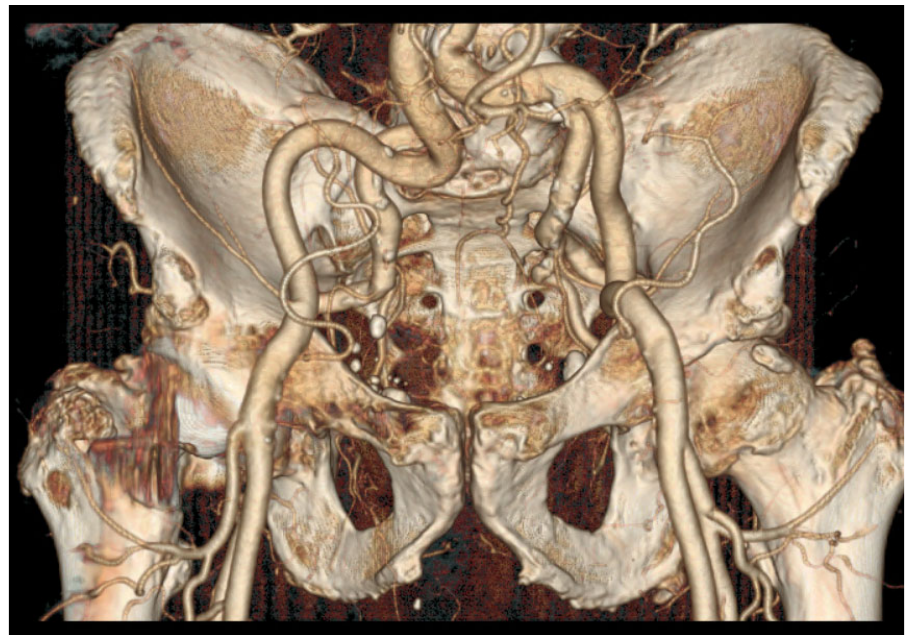
Figure 1. A CT scan with a 3D reconstruction showing very tortuous iliac arteries and very acute right internal/external iliac angulation. Upper radial access was privileged in the first intention.